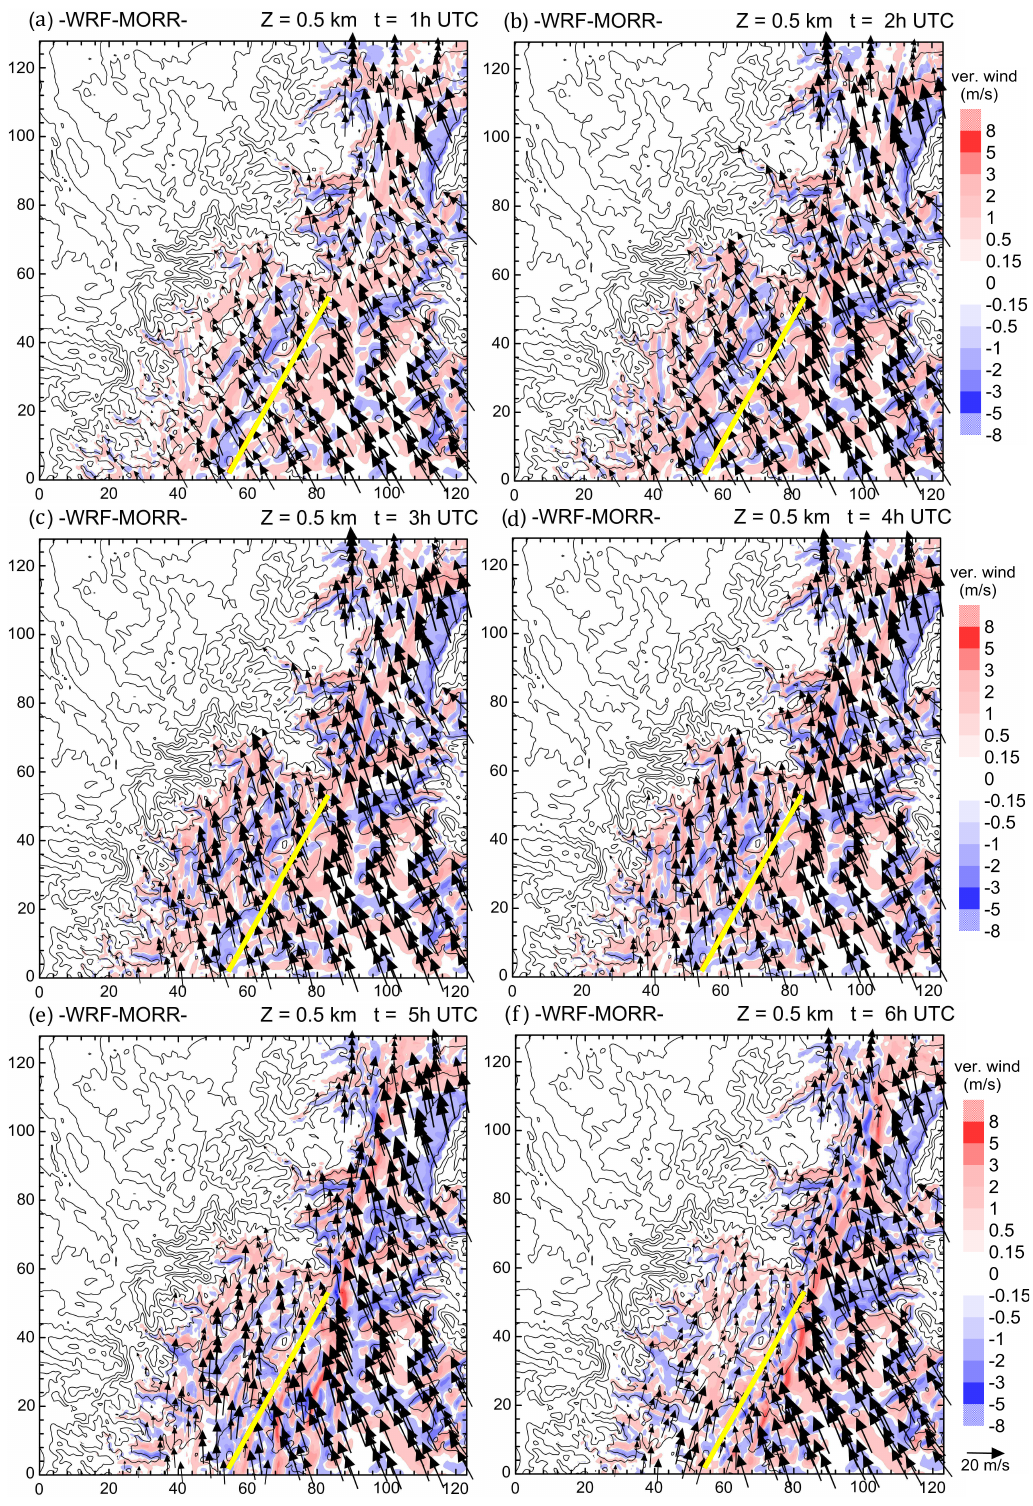
Figure 9. Hourly evolution of the horizontal and vertical wind components simulated from 01:00 to 06:00 UTC ( a – f ) over the innermost domain in WRF-MORR at 0.5 km height. The colour scale represents the vertical wind for which the updrafts and the downdrafts are given with, respectively, positive (red) and negative (blue) values. The horizontal wind is indicated by the arrows. The yellow line indicates the position of the horizontal wind convergence simulated at 07:00 UTC in the WRF simulation (see Figure